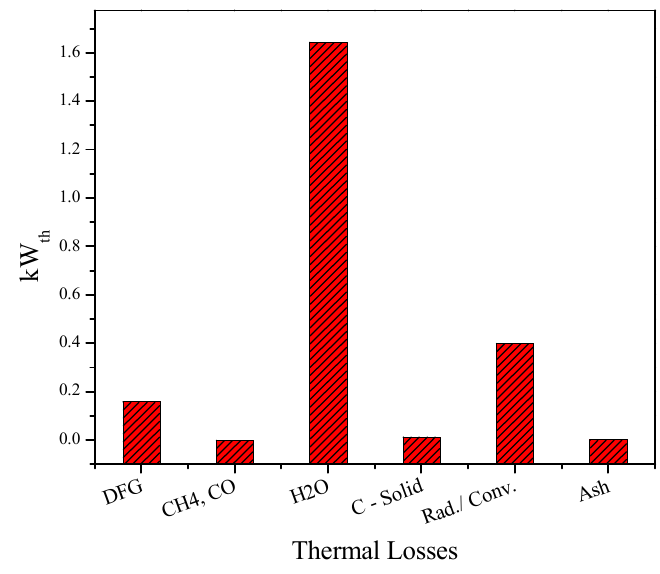
Figure 4. Thermal losses (in kW th ) of the 20 kW th oxy combustion based thermal boiler.